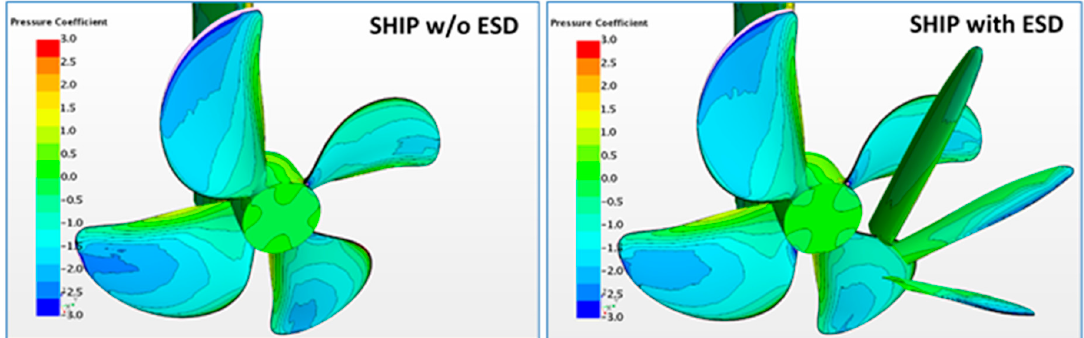
Figure 14. Cavitation domains on propeller and ESD. (PSS-Var-5, full scale, Vs = 14 kn, ballast draught).